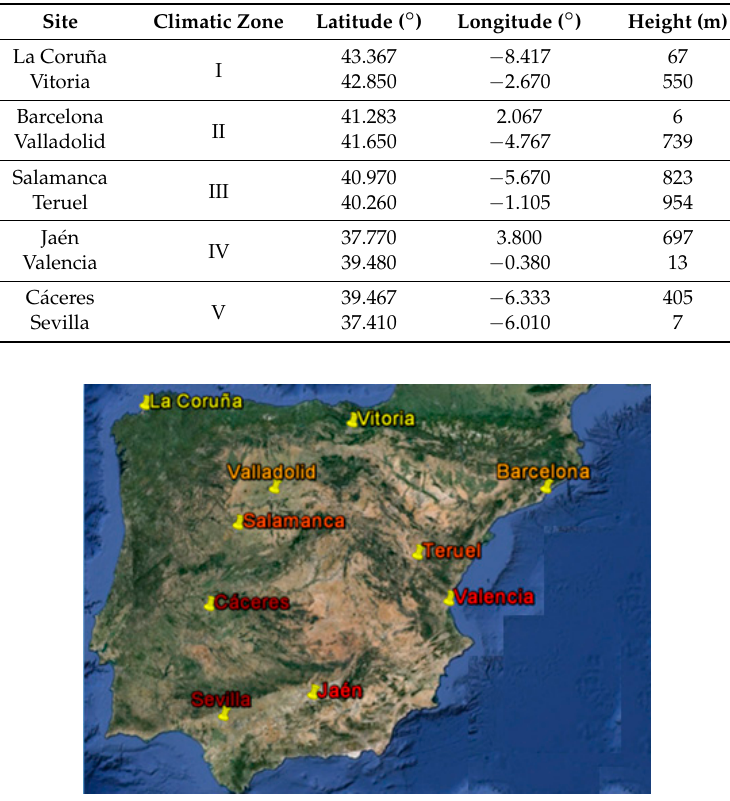
Figure 8. Selected sites. Source: Google Earth.